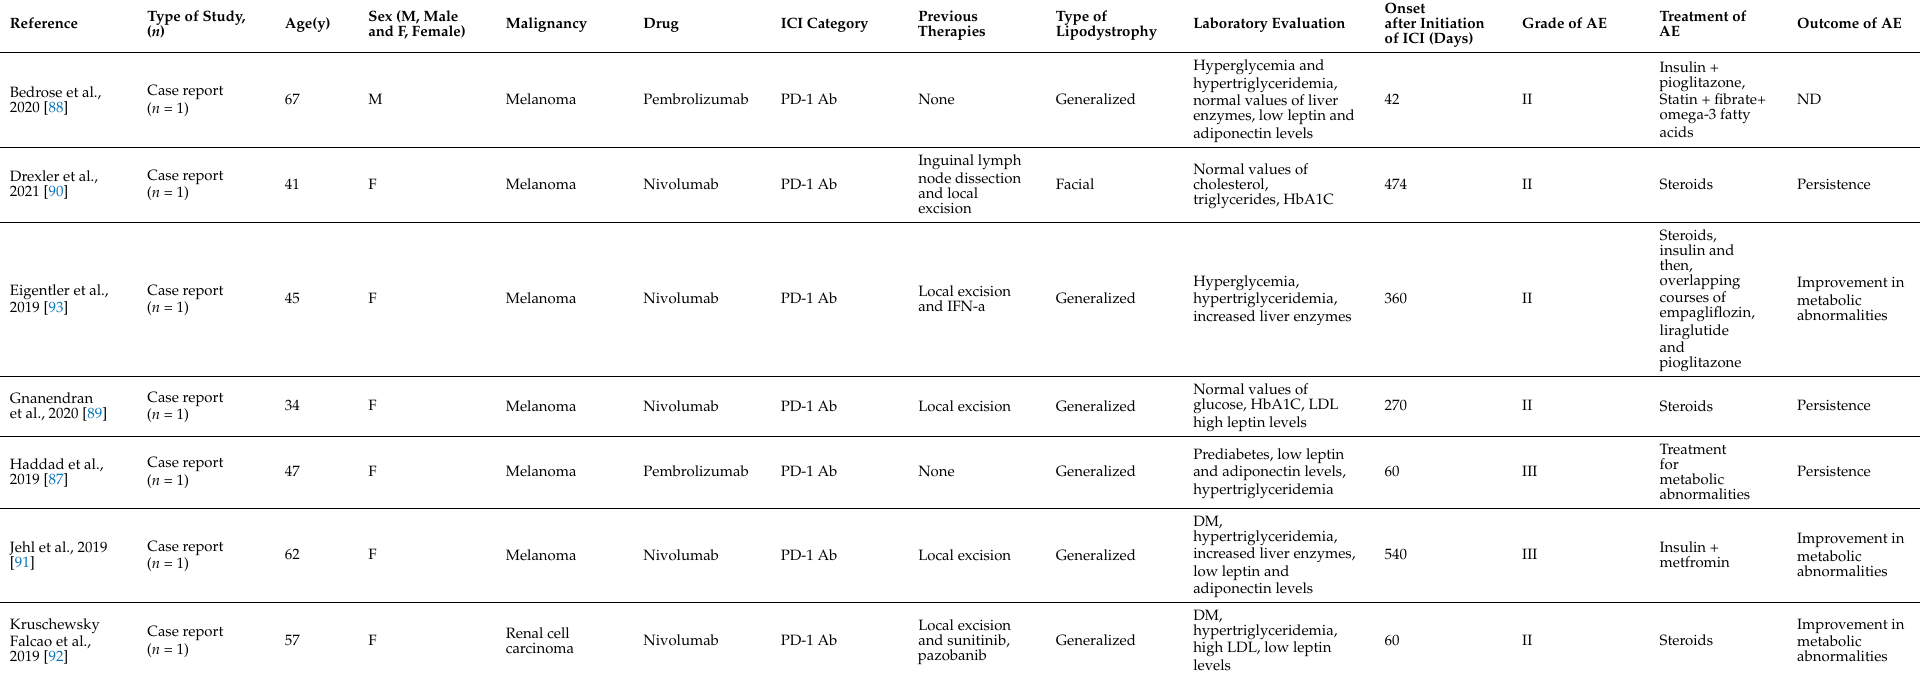
Table 4. Cases in the literature presenting ICI-related acquired